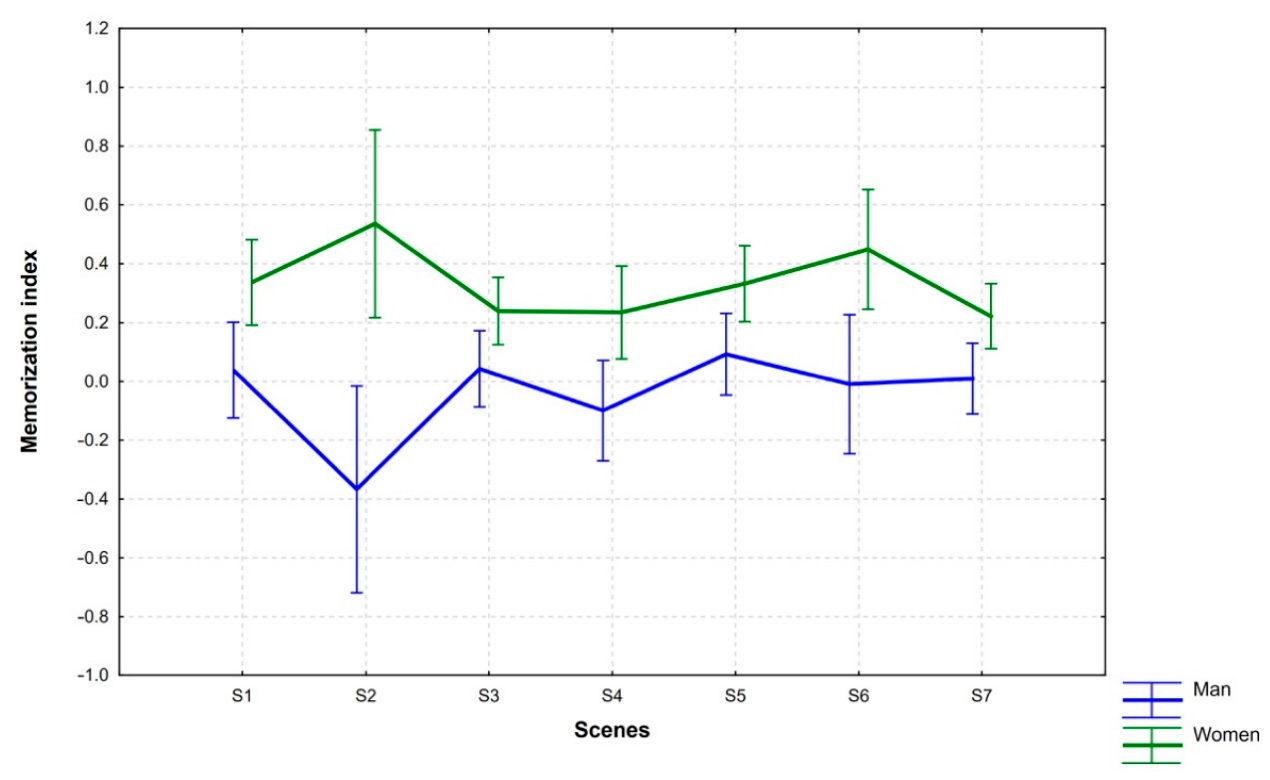
Figure 2. Differences in mean MI values between men and women as regards scenes under study. Women obtained higher mean MI values for all scenes than the male group. Particu- larly in the case of S2, the mean MI values were high (M = 0.536), while for S6 they were slightly lower (M = 0.449). The lowest mean values in the group of women were recorded for S3 (M = 0.24), S4 (M = 0.239) and S7 (M = 0.222). In the group of men, the mean MI values were the highest for S5 (M = 0.093), S3 (M = 0.043), and S1 (M = 0.039), respectively, and the lowest for S2 (M = − 0.367).